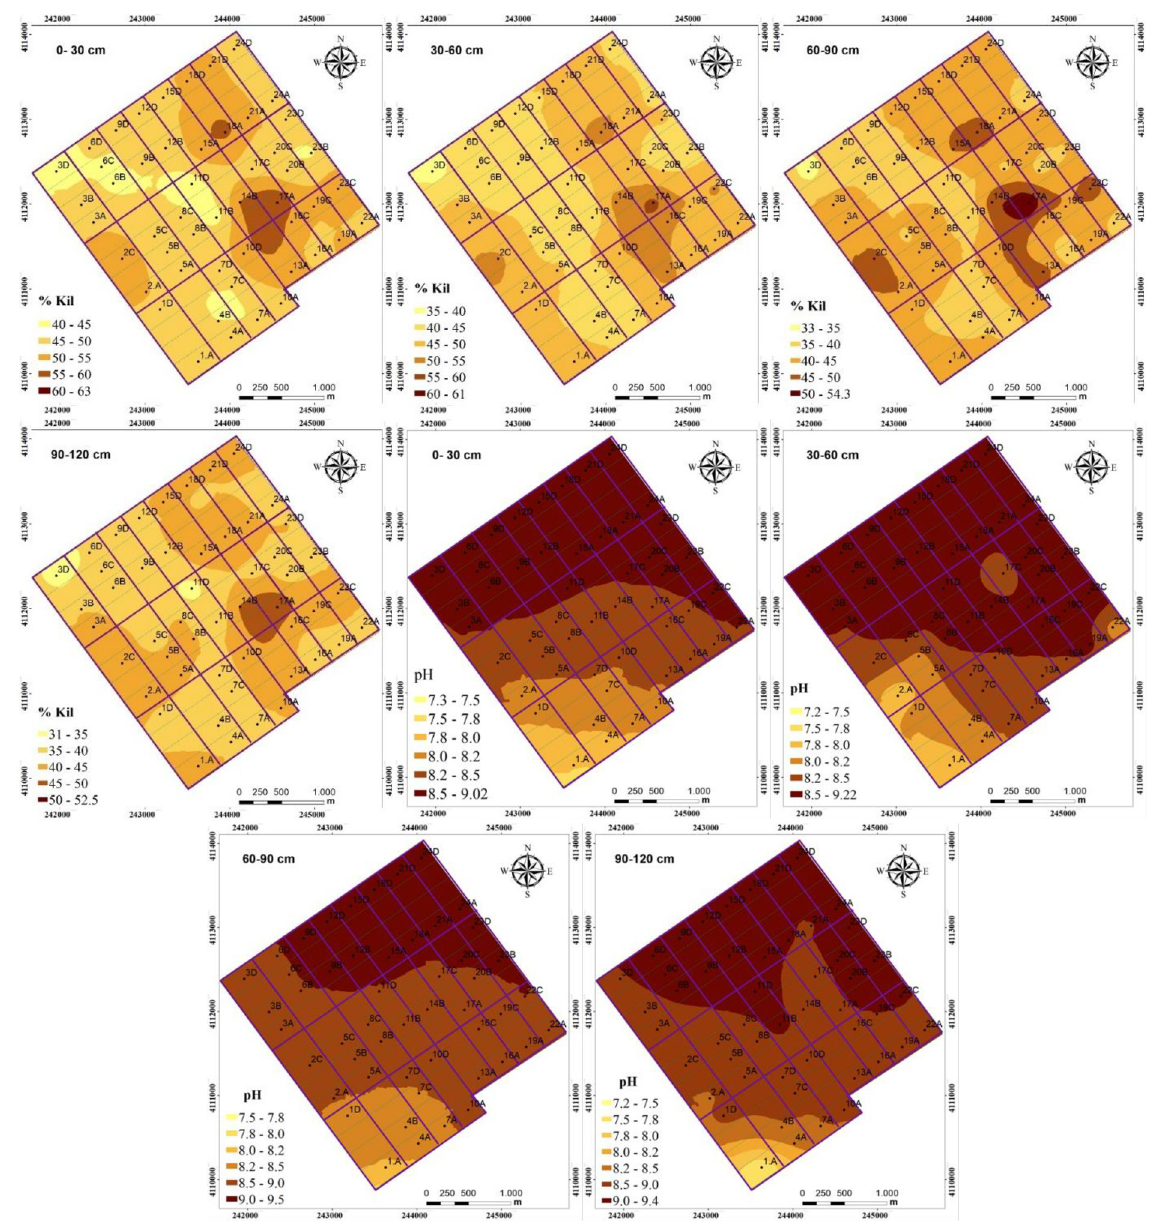
Fig 2. Spatial distribution of clay content and pH values within 0–120 cm of soil